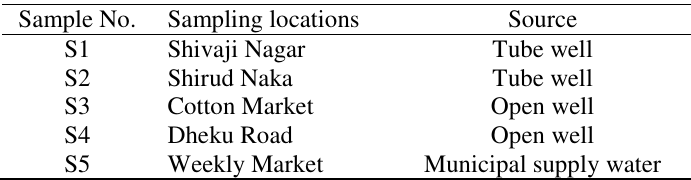
Table 1. Sampling